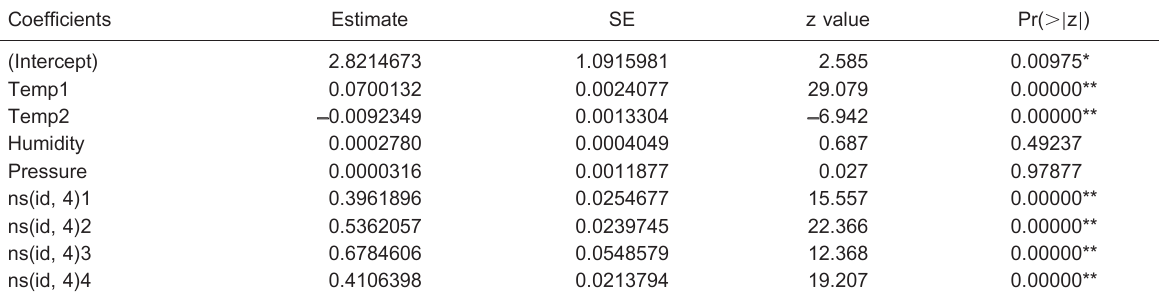
Table 2. Coefficient parameter estimates in generalized additive